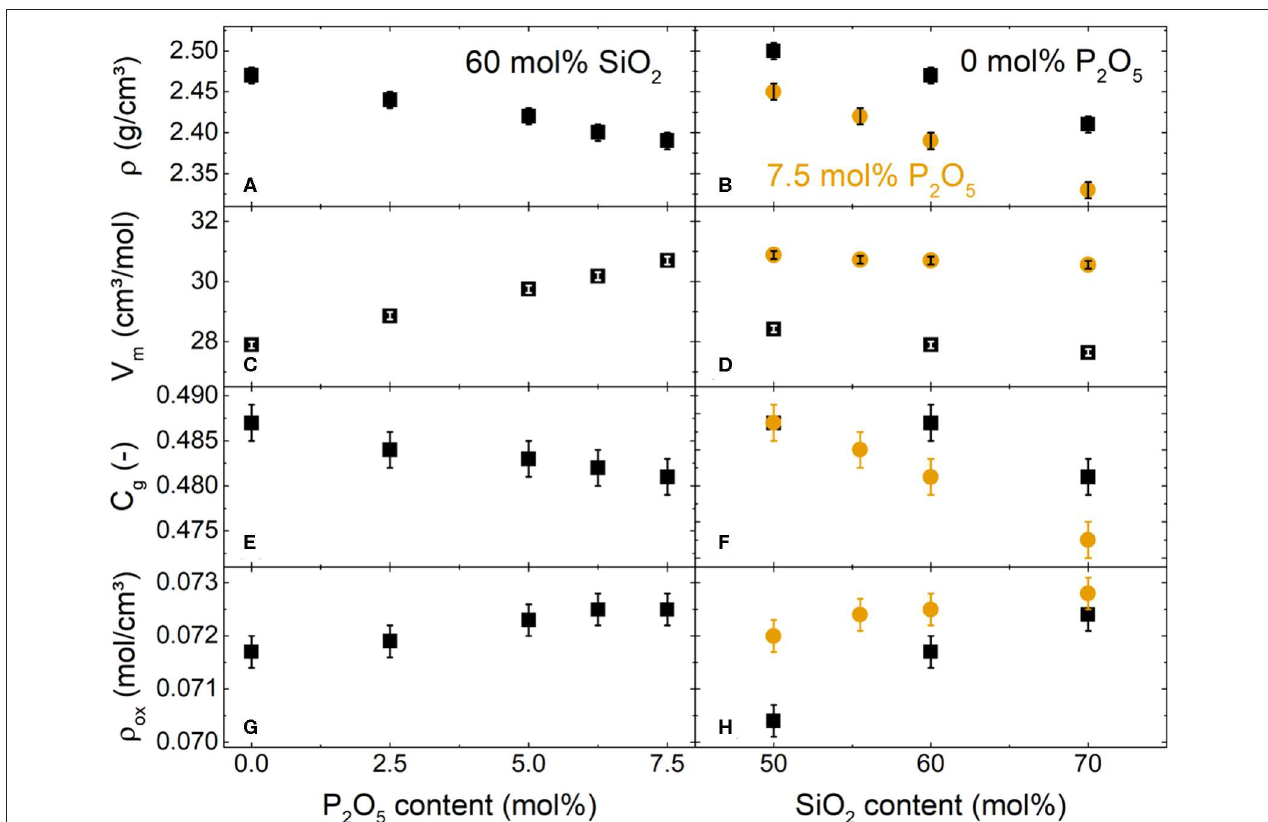
FIGURE 4 | Density (A,B) , molar volume (C,D) , packing density (E,F), and oxygen packing density (G,H) of the glasses with (A,C,E,G) 60 mol% SiO 2 , (B,D,F,H) 0 mol% P 2 O 5 (black squares) or 7.5 mol% P 2 O 5 (orange